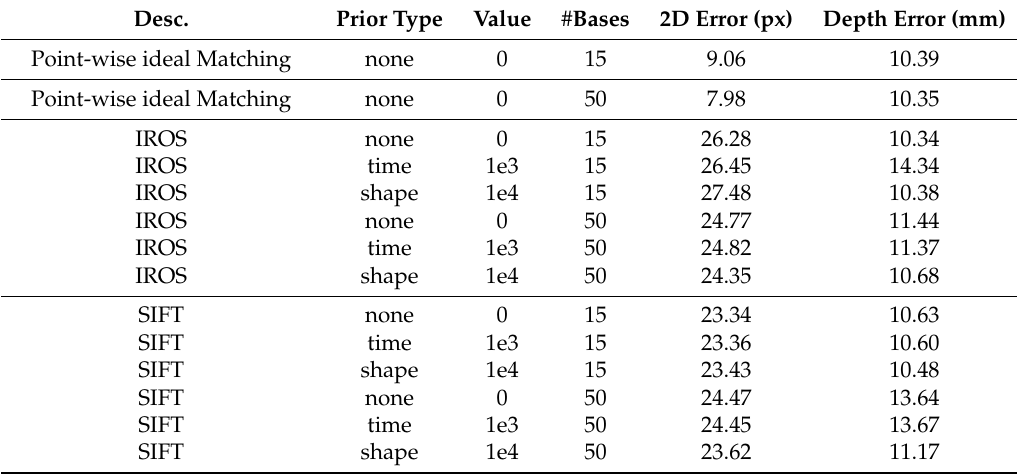
Table 7. Summary of the results for the Kinect paper sequence with different numbers of bases, priors and descriptors.